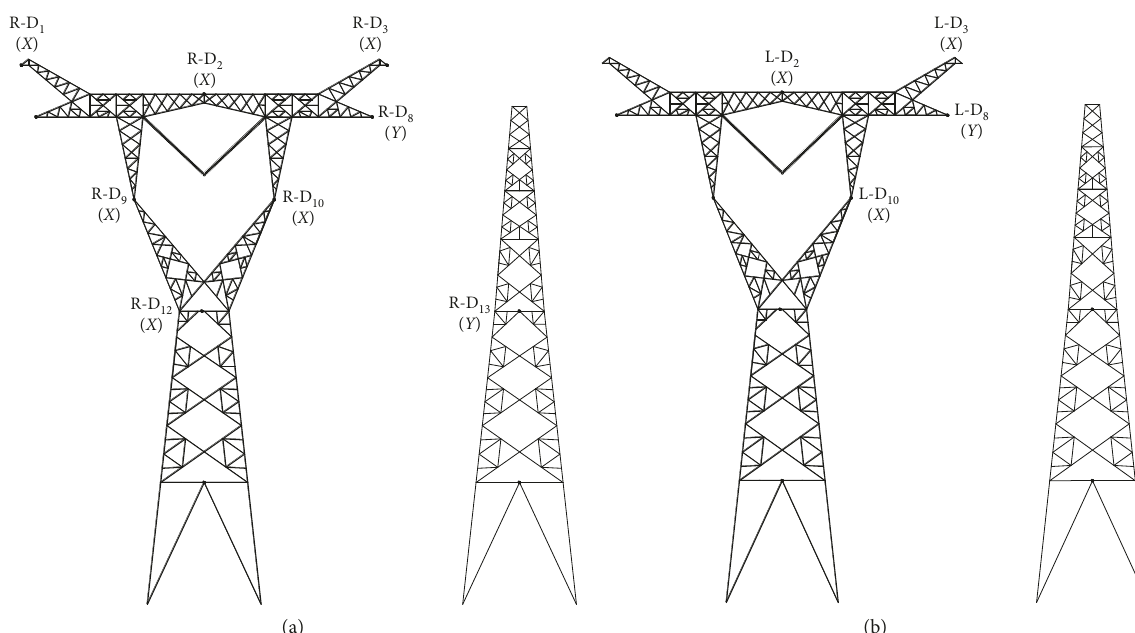
Figure 19: Layout of the displacement sensors on the five-tower-four-line model. Layout of the displacement sensors on (a) the right model tower and (b) the left model